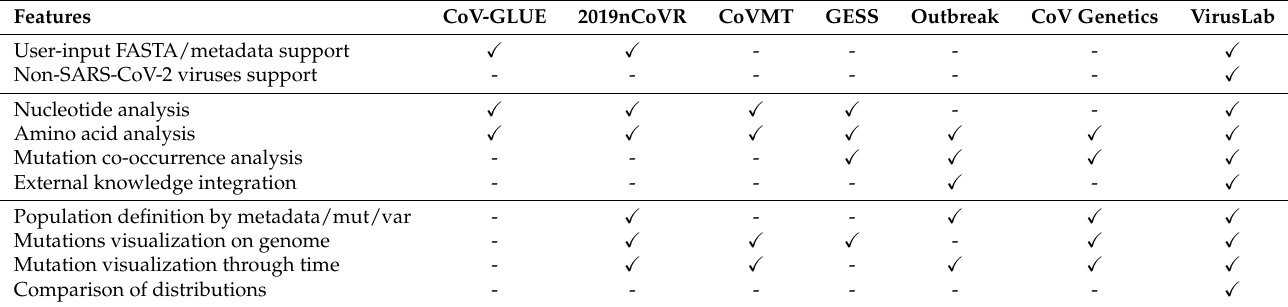
Table 1. Comparison of open access resources for analyzing and visualizing viral